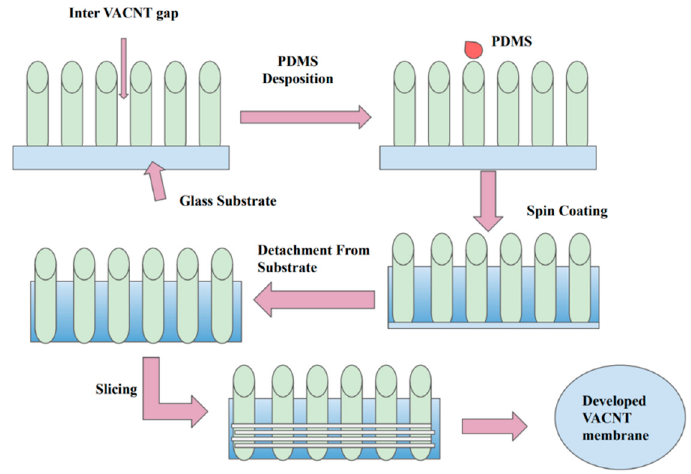
Figure 6. Fabrication process of VA-CNT membrane [63]: VA-CNT grown on silicon support is glued to glass substrate. PDMS is then added through spin coating and cured through heating in a vacuum oven; the volatile part of the PDMS is evaporated through spin coating. Silicon and glass substrates are removed using mechanical peeling (microtome machine).